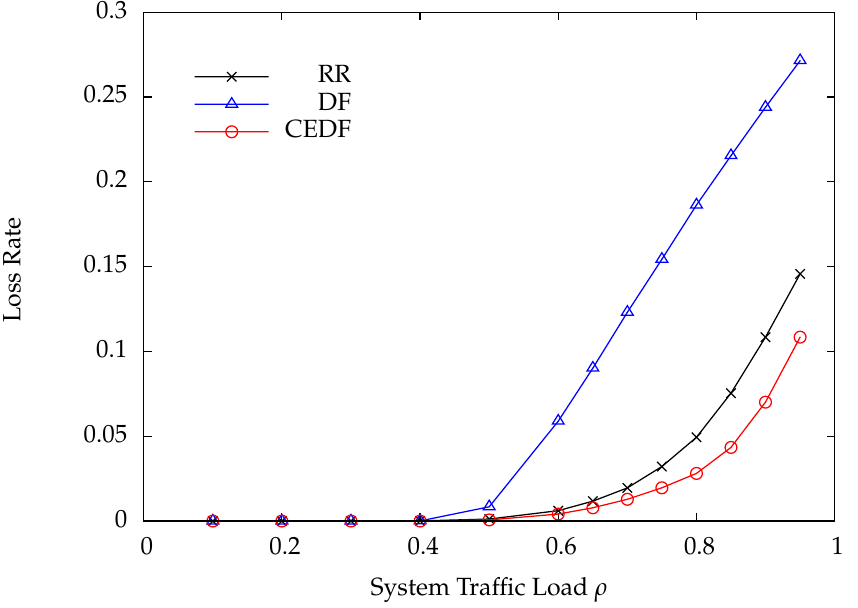
Figure 6. Loss rate versus system traffic load ρ .